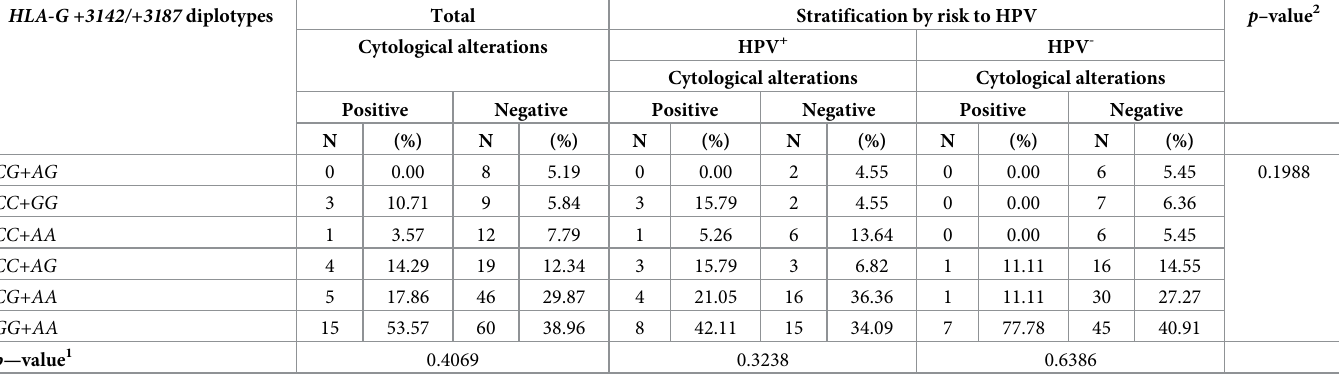
Table 5. HLA-G +3142/+3187 diplotypes, cytological abnormalities and stratified case analysis according to the risk of HPV infection in HIV-infected women. HLA-G +3142/+3187 diplotypes